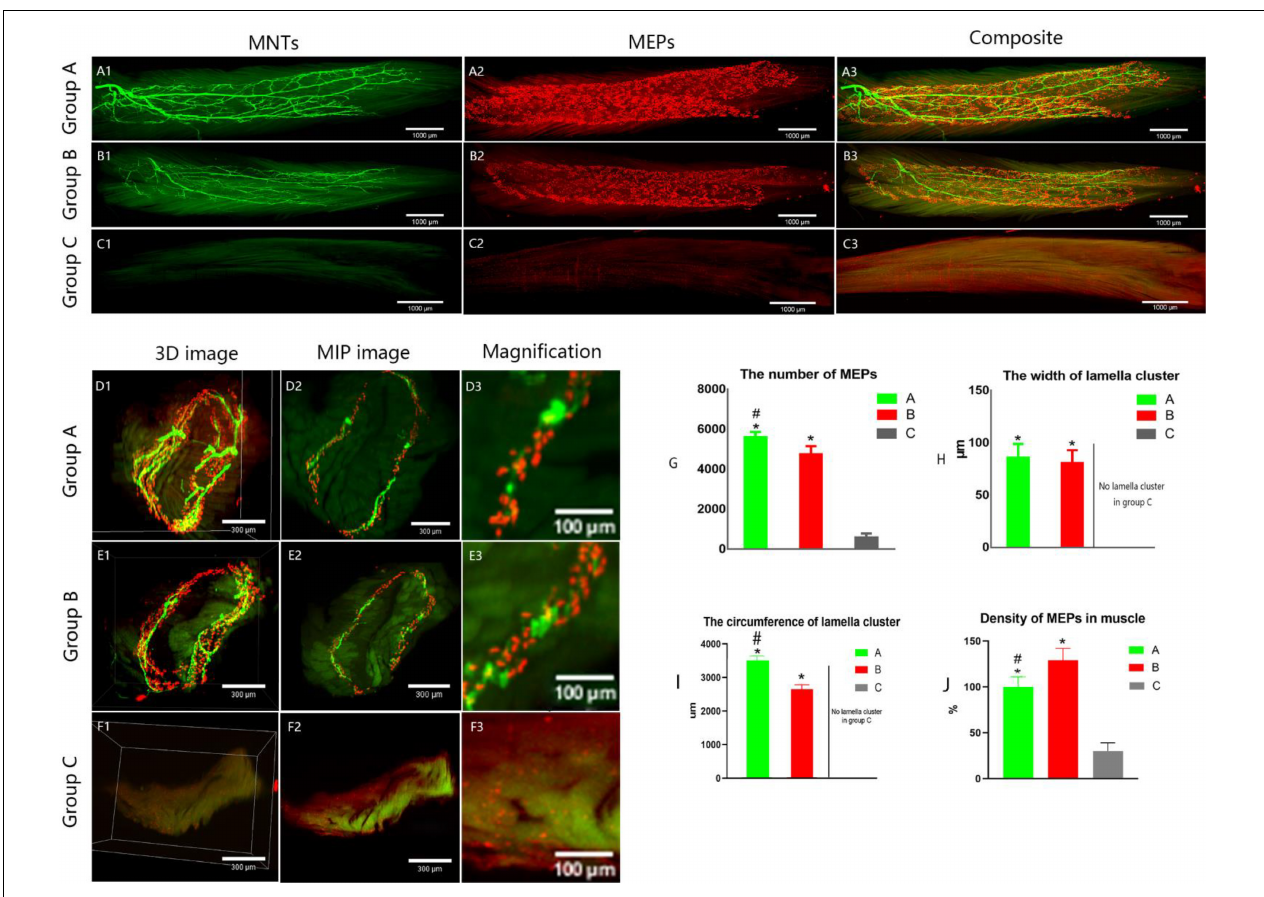
FIGURE 5 | Spatial distribution of the neuromuscular junctions in LFD. AChRs aggregates in the post-synaptic membrane were stained with 647- α -bungarotoxin ( α -BTX), a very potent ligand for AChR (visualized in red). The terminal axon of motor neuron was labeled using Thy1-YFP-16 mice (shown in green). (A1–C3) The three-dimension distribution of NMJs. Calibration bar: 1000 µ m. (D1–F3) The cross-sectional images of NMJs. Panels (D3, E3, F3) show the width of the MEP lamellas which were the enlarged images ( D2, E2, F2 , respectively). Calibration bar: 300 and 100 µ m. (G) The total number of MEPs in LFD, (H,I) The width and the circumference of lamella cluster of NMJs. There is no obvious lamella cluster in C group (F1–F3) . (J) The density of MEPs in LFD (ratio of the total number of MEPs to the volume of FDL). (A, normal control group, B, proximal peroneal nerve-repaired distal tibial nerve group, and C, unrepaired tibial nerve group, n = 6 for each group, * p < 0.05 vs. C group, # p < 0.05 vs. B group. Bars = SD).